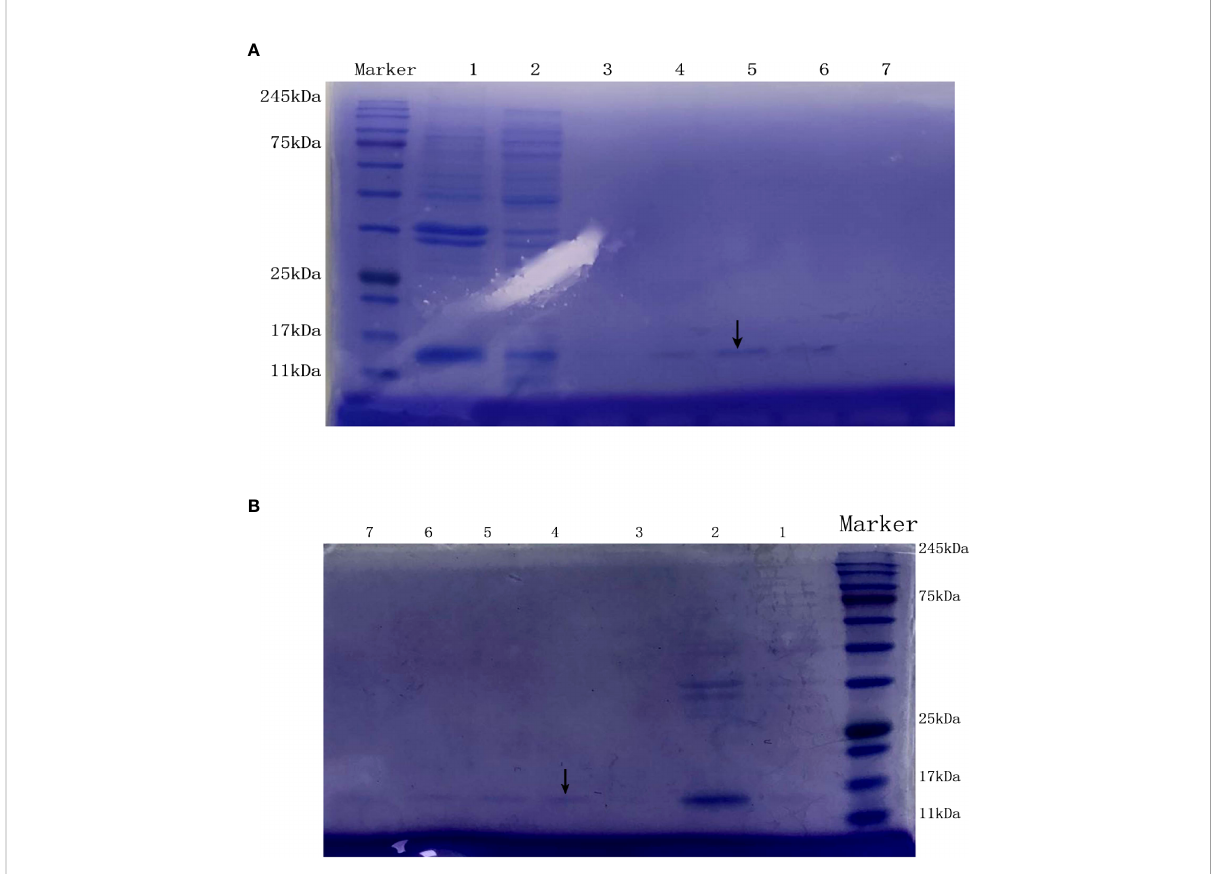
FIGURE 3 The SDS-PAGE of the anti-restriction protein KlcA (A) and KlcA HS (B) . Lanes 1 and 2 are the precipitate and supernatant of E. coli BL21 (pET20b- KlcA) obtained by ultrasonic fragmentation without puri fi cation, respectively. Lanes 3, 4, 5, 6 and 7 are the target protein KlcA with His tag obtained after puri fi cation with 100 mM-500 mM imidazole-eluting nickel columns, located at the positions indicated by